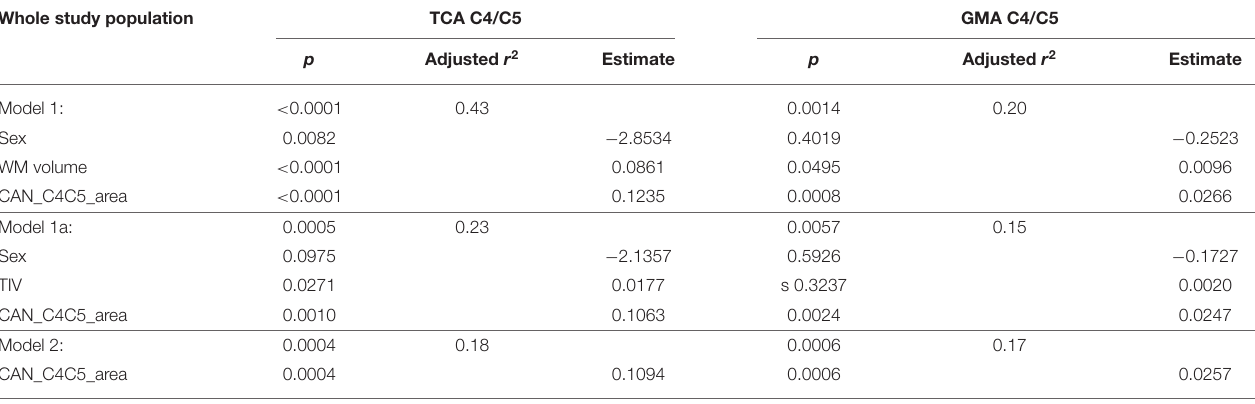
TABLE 3 | Linear regression analysis with total cross-sectional area (TCA) at the C4/C5 level as outcome and normalization variables after backward selection; corresponding models with gray matter area (GMA) as outcome. Whole study population